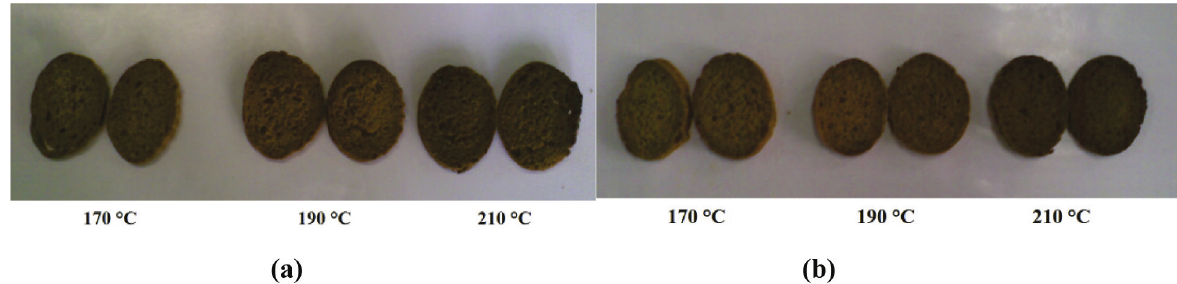
Figure 3 - Images of W-15CMP ( a ), and W-15CM ( b )